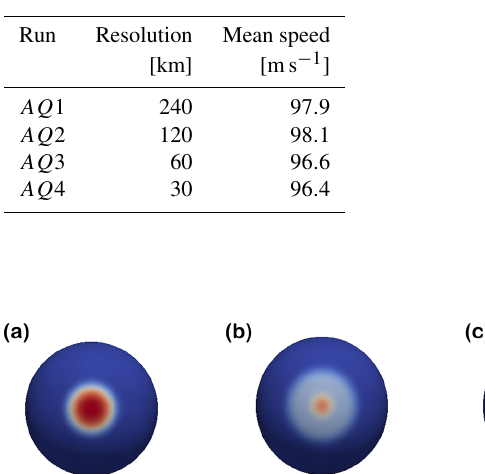
Table A1. Parameters for an Aquaplanet test case simulated using MPAS-Ocean.